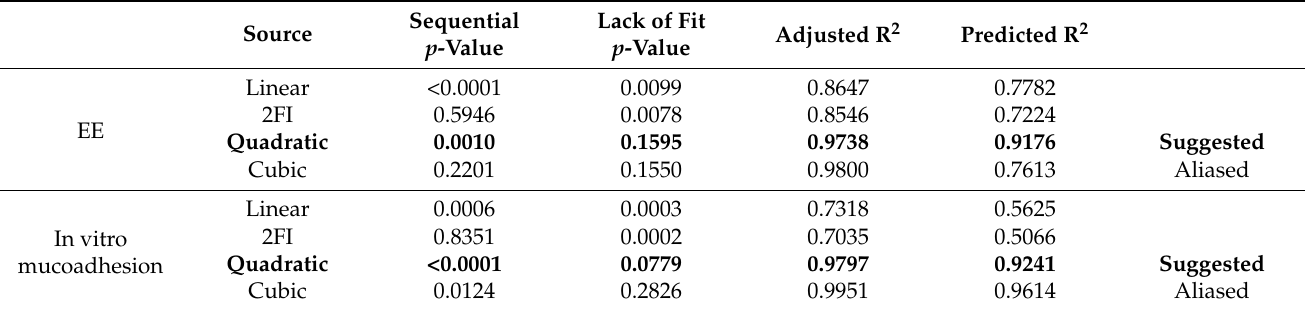
Table 4. Model summary statistics of selected responses.